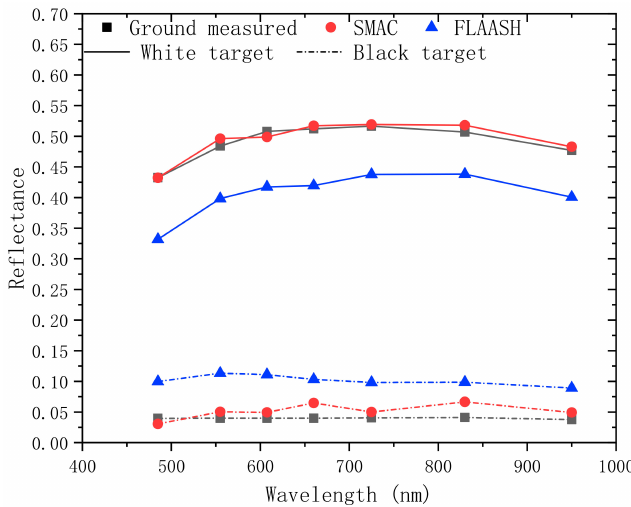
Figure 12. Images of Songshan on 4 February 2021. ( a ) Original image; ( b ) corrected image after Syn-AC; ( c ) corrected image after FLAASH. The retrieved AOD at 550 nm and retrieved CWV are 0.421 and 0.42 g/cm 2 , respectively.